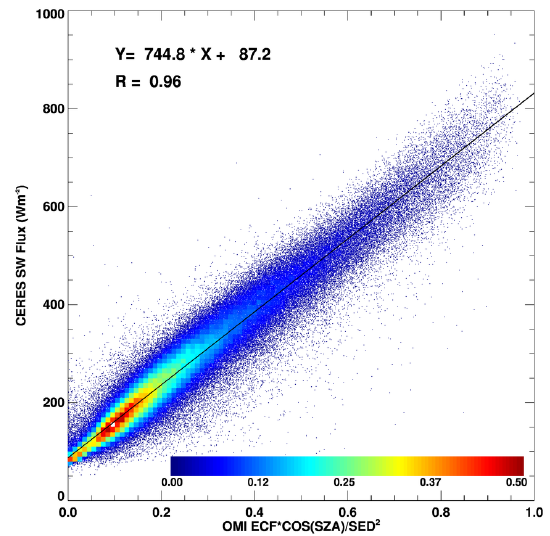
Figure 2. Two-dimensional histogram of effective cloud fraction (ECF or f c ) normalized with respect to incoming solar irradiance (i.e., f c_mod = ECF × cos(SZA) / SED 2 ) vs. CERES TOA short- wave (SW) flux over ocean for January 2007 showing a highly lin- ear relationship. The color bar shows the sample density (normal- ized, in terms of fractional amount, in percent) for each bin in the collocated data set; when only a single point is in a bin, it is shown as a dark blue dot. R is the linear correlation coefficient. The solid black line is a linear fit to the